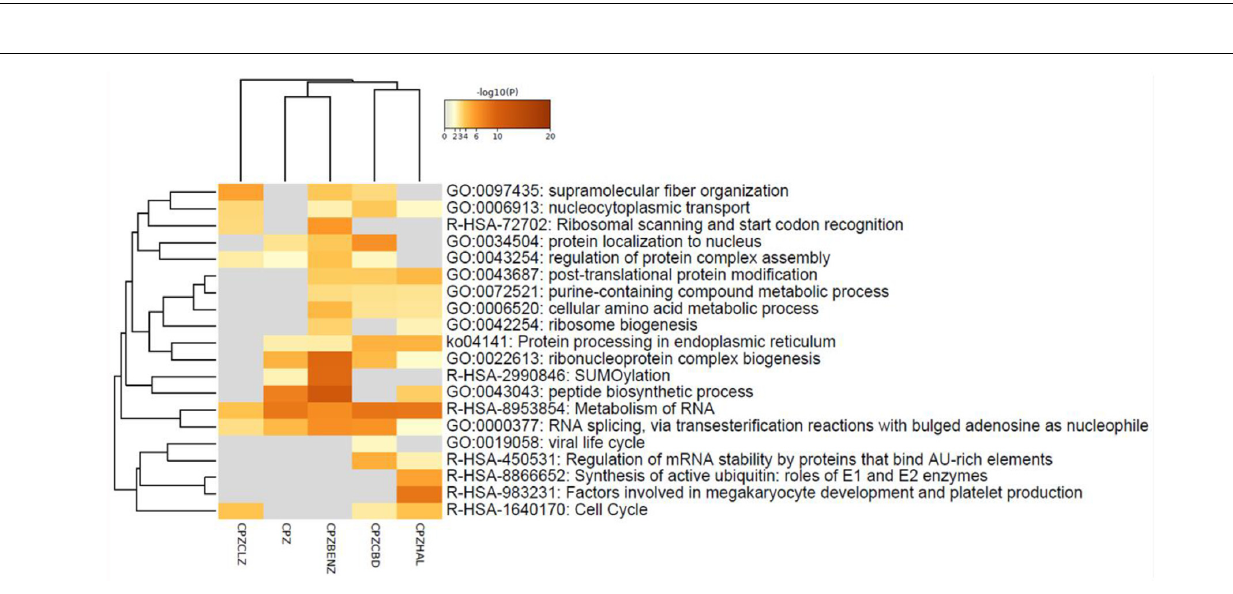
molecular mechanisms against cuprizone-mediated toxicity in MO3.13 cells. Cuprizone insult resulted in changes in proteins related to metabolism and genetic processes, both of which were also modulated by benztropine treatment. More